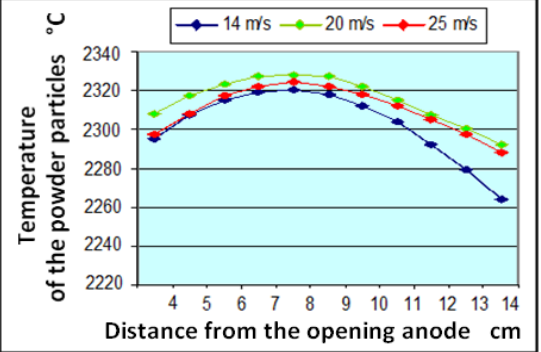
Figure 2 – Temperature of the surface of particles depending on the speed of injection and